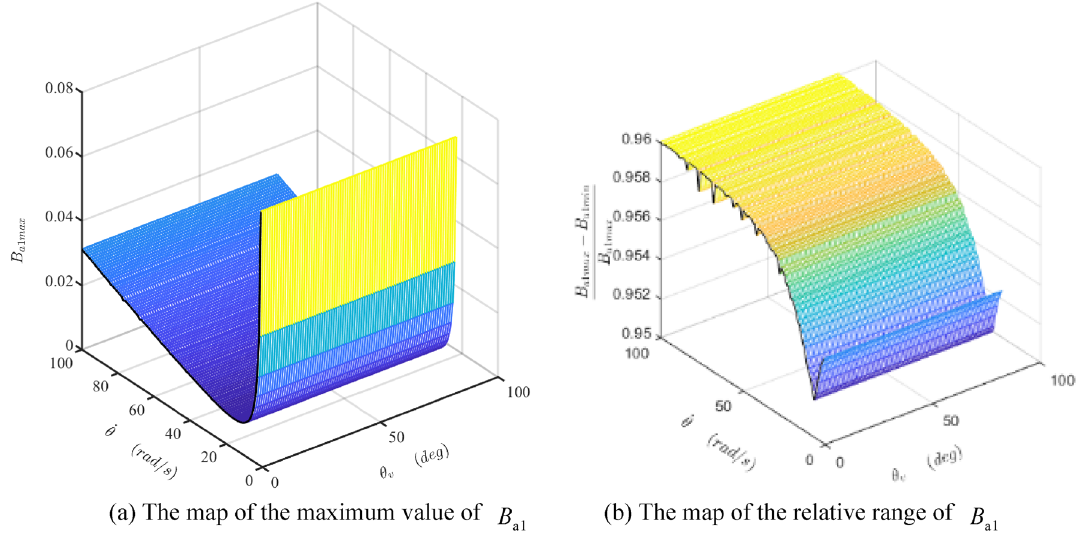
Figure 14. The maps of the maximum value and the relative range of the damper coefficient B a1 . (Matlab2019a. https:// ww2. mathw orks. cn/ produ cts/ get- matlab. html?s_ tid= gn_ getml).